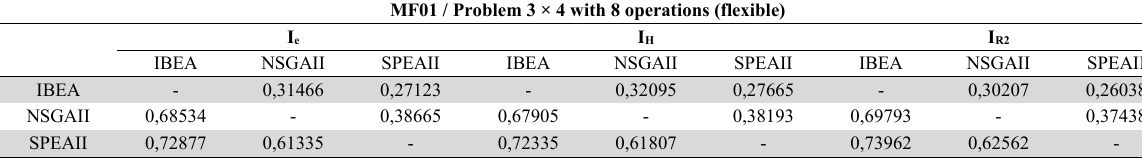
I e , I H , and I R2 (MF01) for IBEA, NSGAII and SPEAII